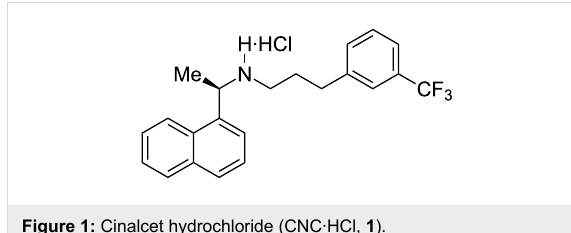
Figure 1: Cinalcet hydrochloride (CNC·HCl, 1